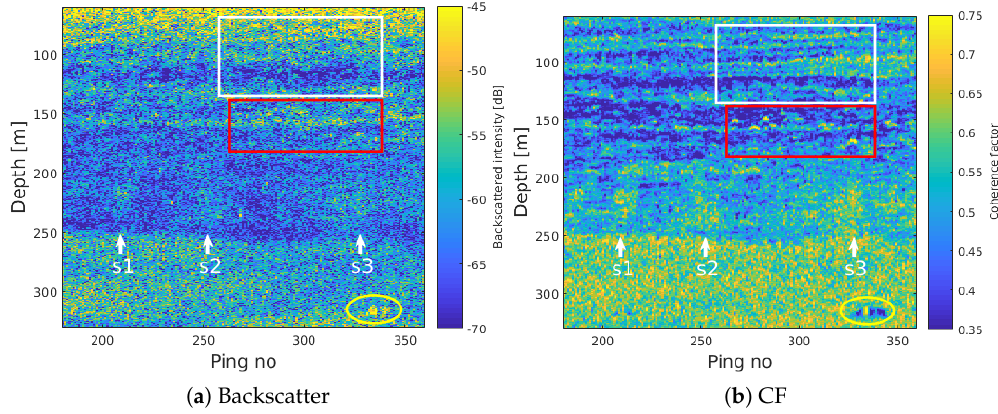
Figure 4. Enlargement of a region of interest from Figure 3f, showing more detail in the CF image. Single scattering objects, most likely from single fish or bubbles, can be seen in the CF image as regions of high coherence and the characteristic curved shape. Also, 3–4 flares can be tracked above the DSL, to a depth of around 200 m. A vertically extended, coherently scattering region is visible in both the echogram and in the CF image around ping 335, possibly related to a school of fish or a marine